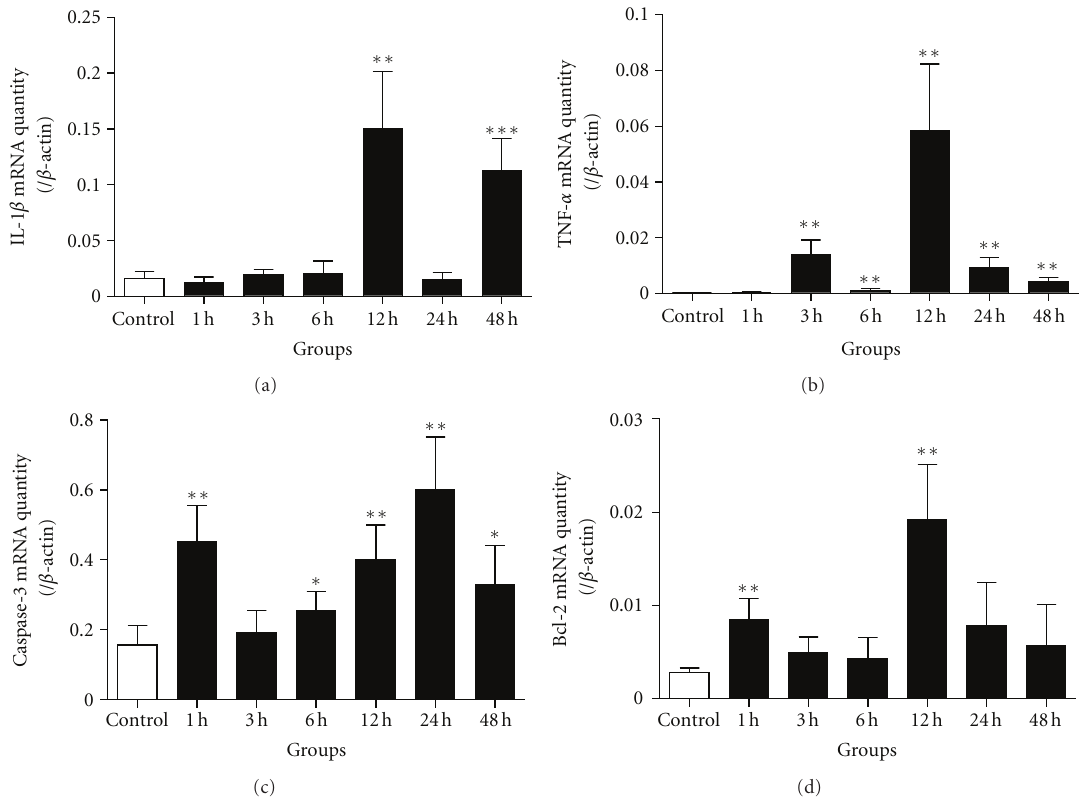
Figure 6: The mRNA levels of NF- κ B downstream genes were detected by real-time PCR in Hb-incubated neurons. (a) IL-1 β gene expression was increased significantly in 12 h and 48h groups, which showed a biphasic increasing. (b) TNF- α gene was dramatically elevated in the groups after 1 hour. There were two TNF- α expression peaks in 3h and 12 h groups. (c) Caspase-3 gene expression also showed two peaks in 1h and 24h groups; (d) Bcl-2 gene expression was increased in 1 h and 12 h groups. ∗ P < 0 . 05, ∗∗ P < 0 . 01, and ∗∗∗ P < 0 . 001 versus control group. Bars represent the mean ± SEM ( n = 6, each